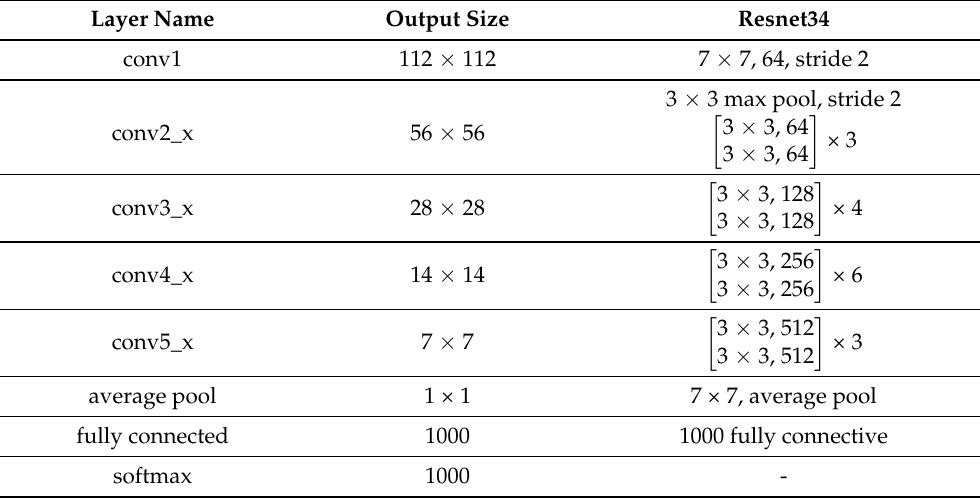
Table 2. Resnet34’s